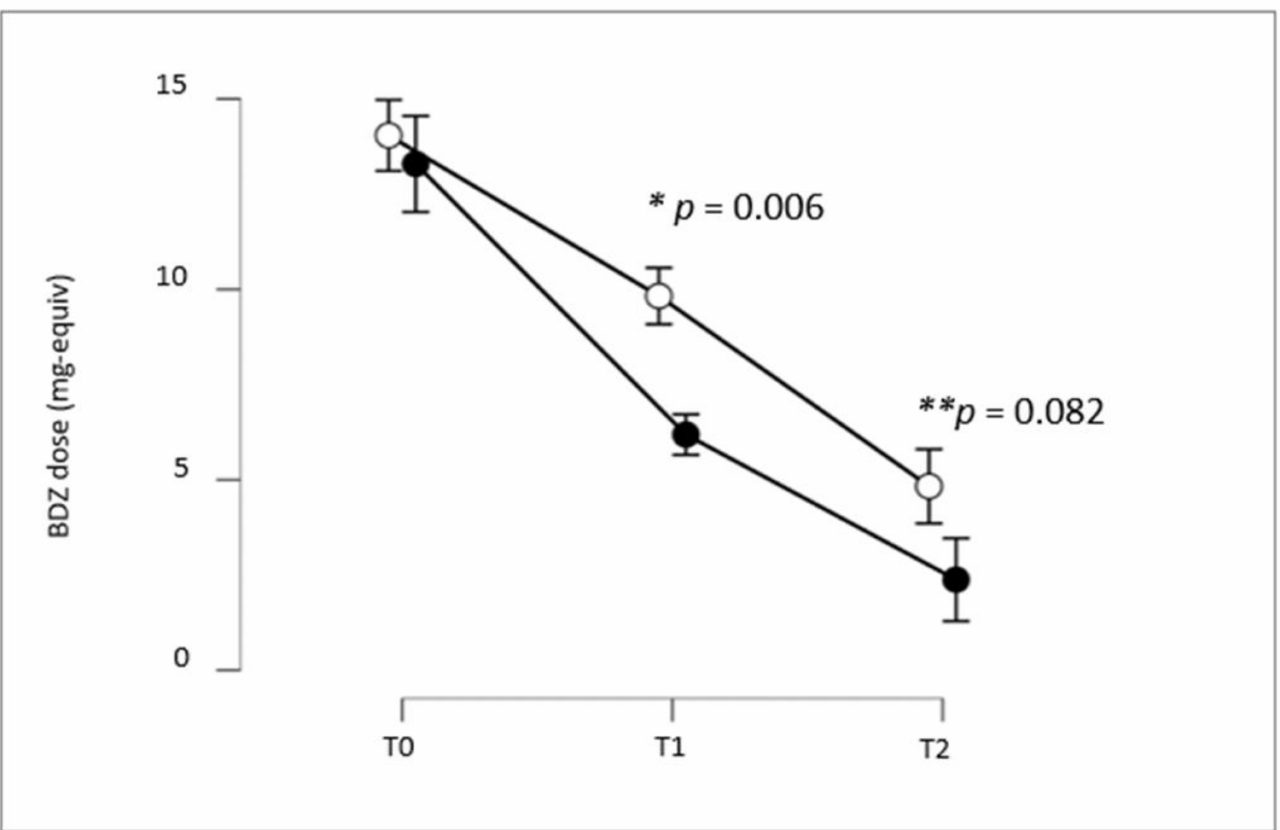
Figure 1. Means (black and white circles are, respectively, Group A and Group B) and 95% confidence intervals (vertical bars) of the BDZ dosage (mg-equiv) at baseline/pretreatment (T0), at the end of the first month of treatment (T1), and at the end of the third month of treatment (T2). * rANOVA post hoc comparisons Group A vs. Group B at T1; ** rANOVA post hoc comparisons Group A vs. Group B at T2. Holm’s post hoc comparisons confirmed that BDZ dosage showed a significant de- crease within the two groups at each time point (Group A: T0 vs. T1, mean